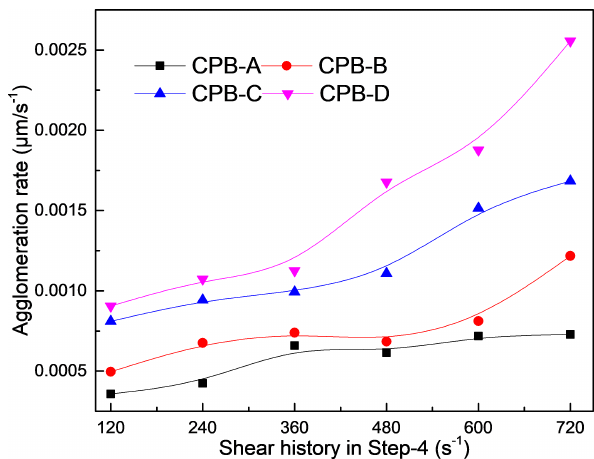
Figure 14: Approximated agglomeration rate in different CPBs pre- pared at different shear histories.